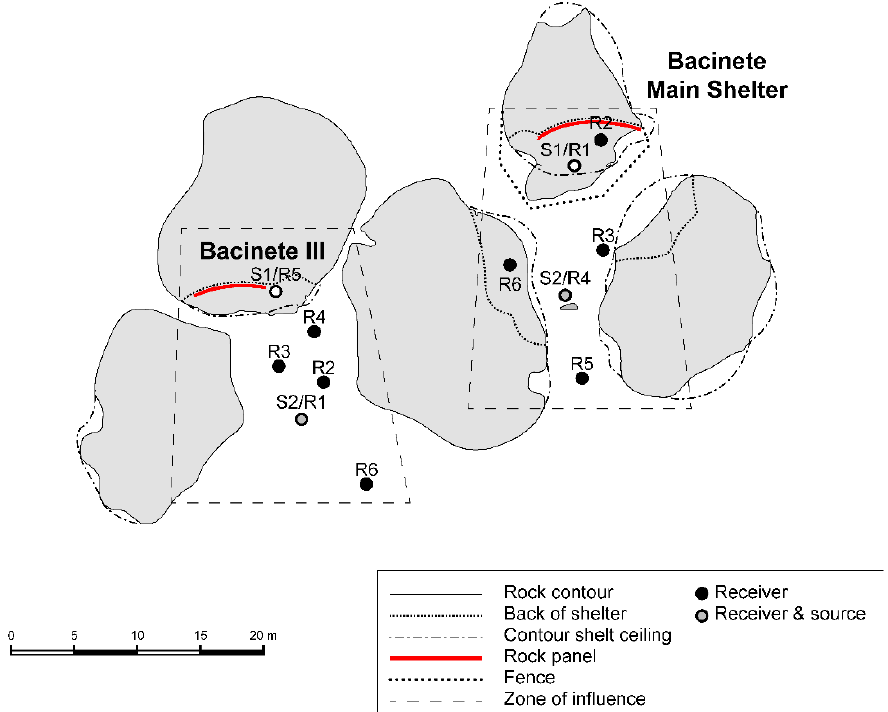
Figure 1. Location of Bacinete main shelter and the Bacinete III shelter in the core rock art area. The approximate sound source (S) and receiver (R) positions set for registering impulse responses are shown. Source: Prepared by the authors based on Lazarich et al. [21] (Figure 5).